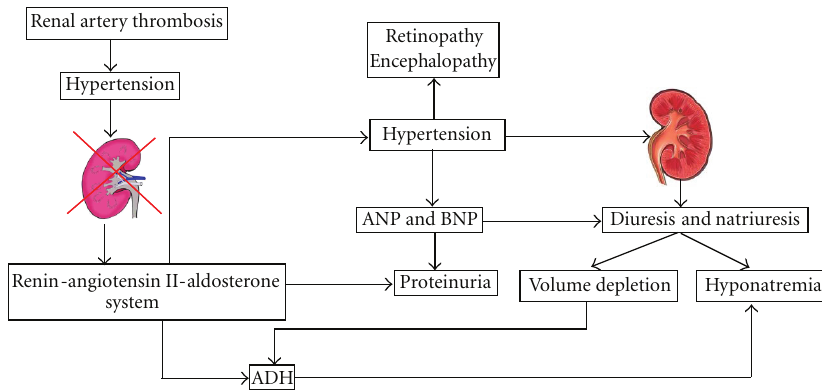
Figure 1: Suggested pathophysiology of the hyponatremic hypertensive syndrome, based on data from Nicholls 2006